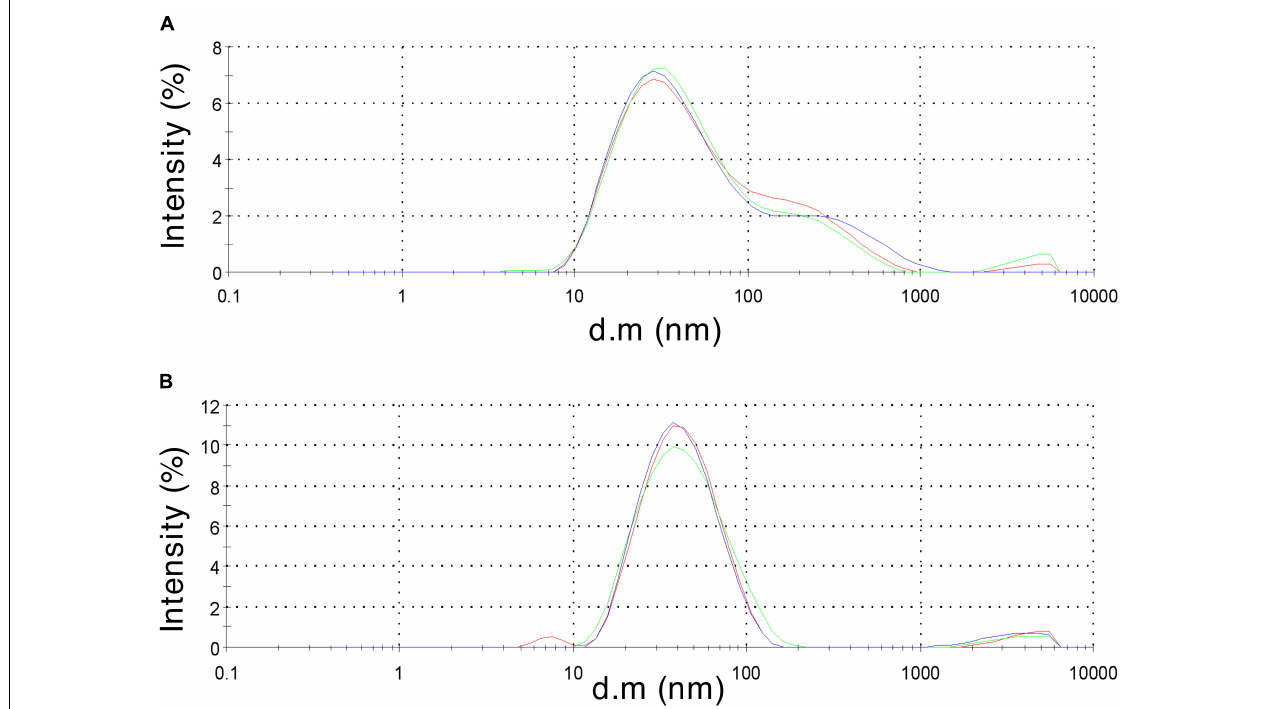
FIGURE 3 | Dynamic light scattering measurements to characterize particle size distribution of the assembled HBc VLPs. (A) HBc VLPs obtained from incubation in assembly buffer in the absence of CIP (untreated assembly) (B) HBc VLPs obtained from incubation in assembly buffer supplemented with CIP (CIP-treated assembly). Samples are displayed as intensity percentage with three technical replicates.